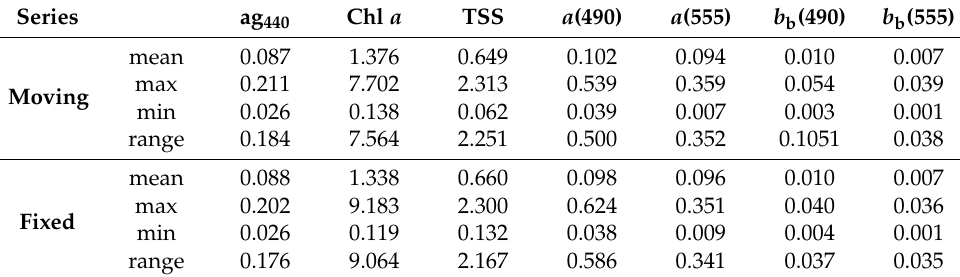
Table 4. The overall variation at all matched